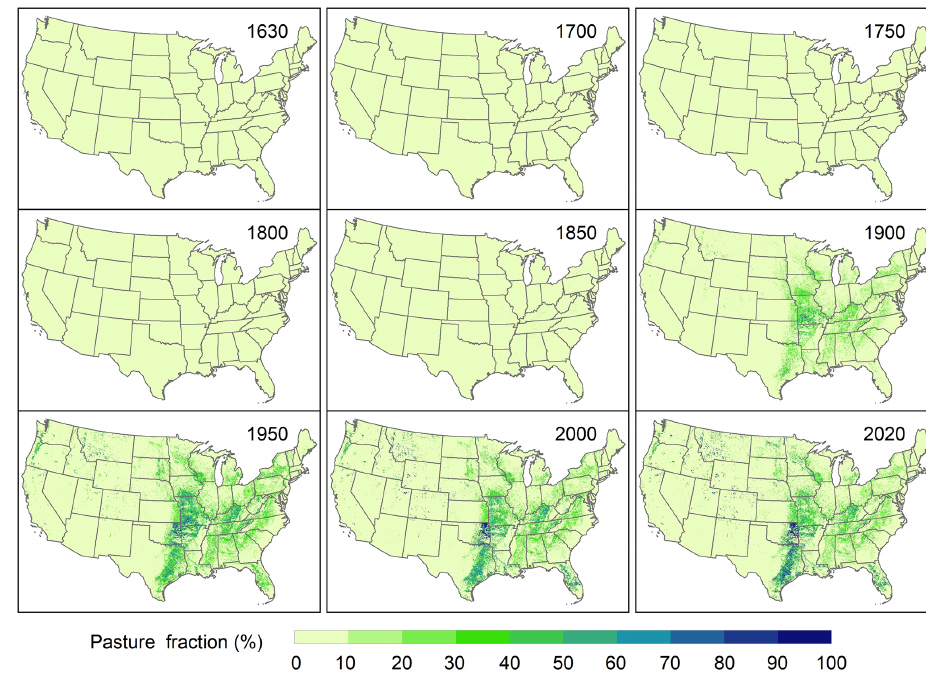
Figure A4. Fractional area of pasture in the conterminous United States during 1630–2020.